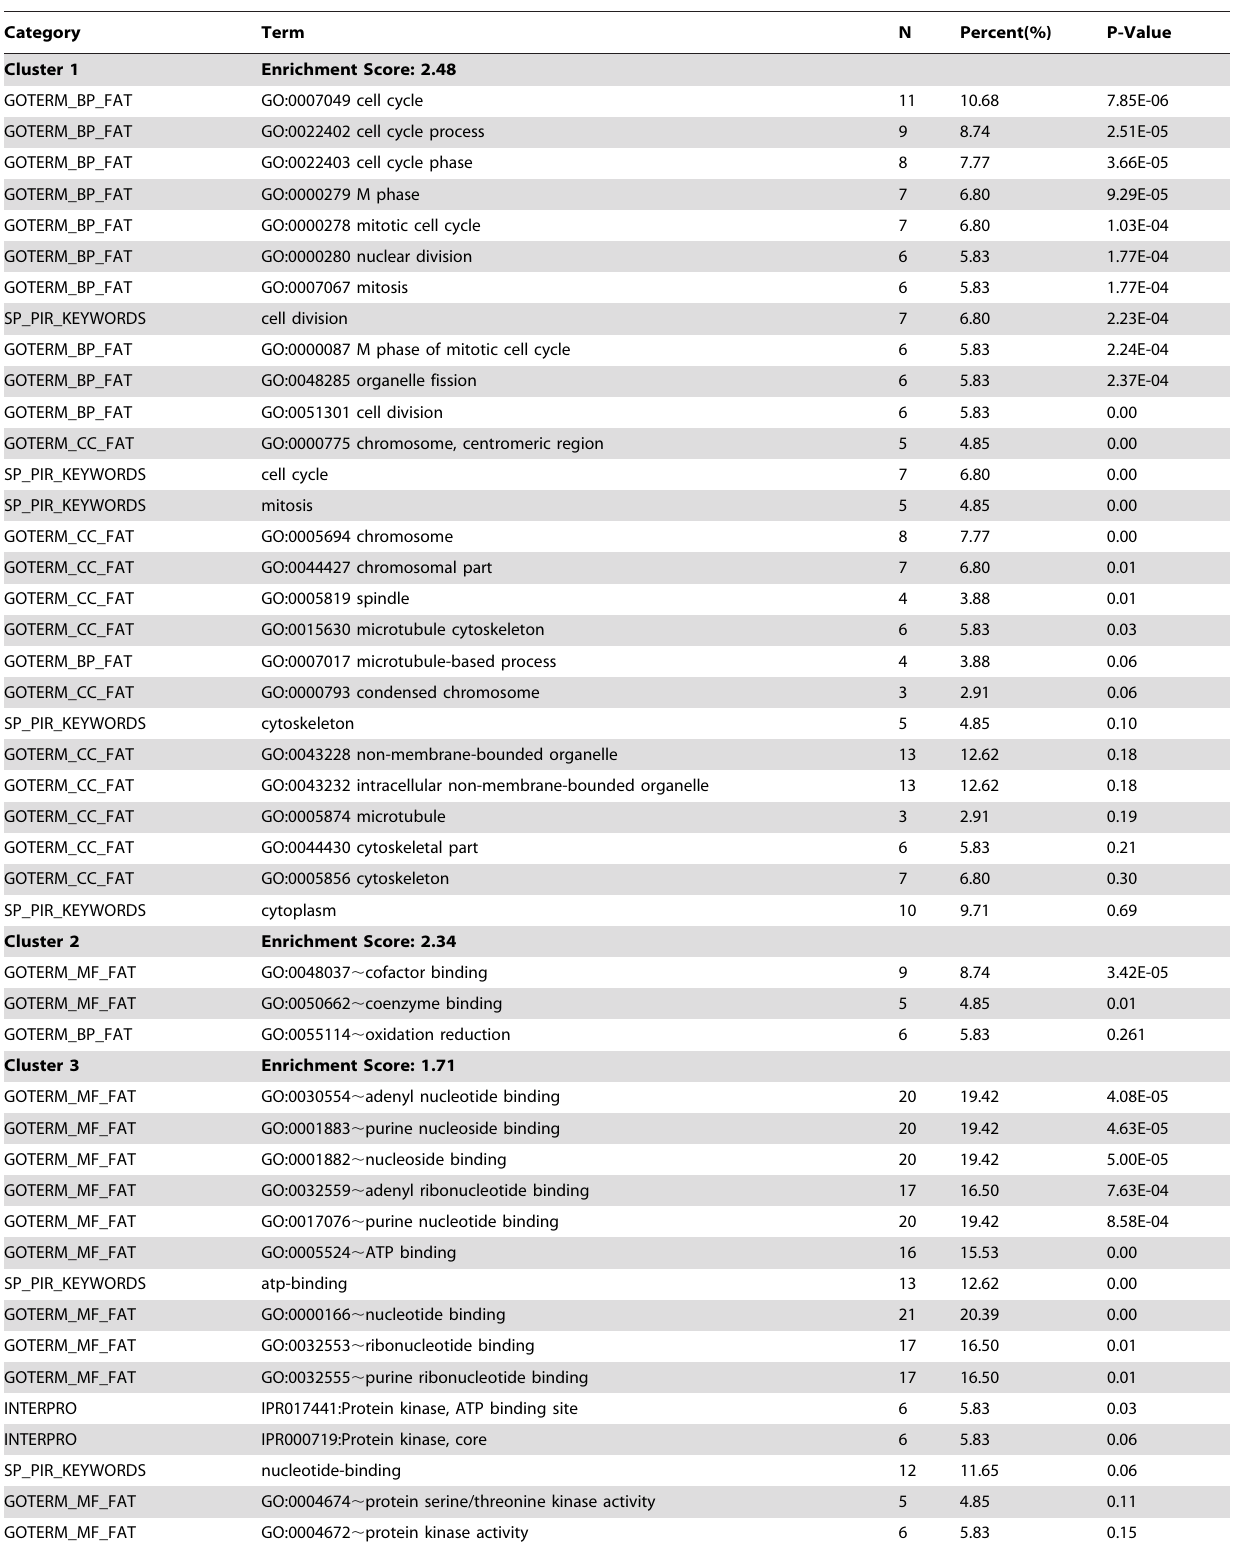
Table 8. Functional annotation clustering of genes upregulated during stage I and then downregulated during stage II of